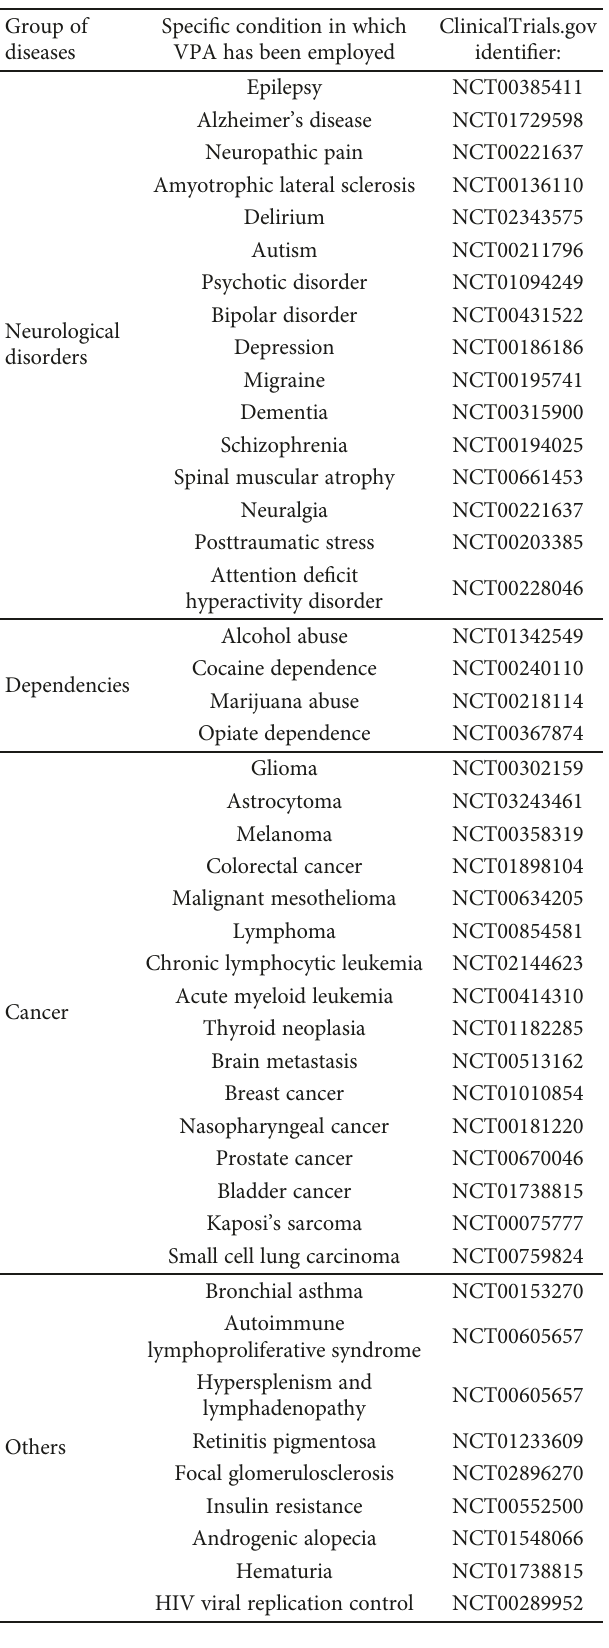
Table 1: Employment of valproic acid in clinical trials. Group